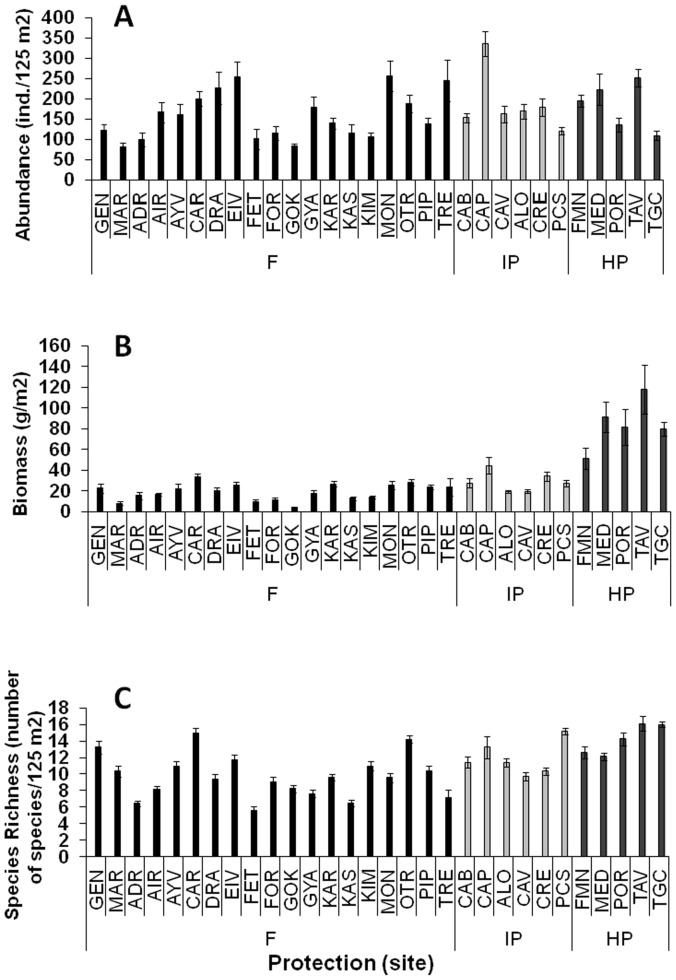
Mean values (± SE) of a) total fish density, b) total fish biomass, and c) fish species richness at each sampling site (see Figure 1 for complete site names).Black bars indicate fished areas (F), light gray bars indicate intermediate protected MPAs (IP) and dark gray bars indicate highly protected MPAs (HP).